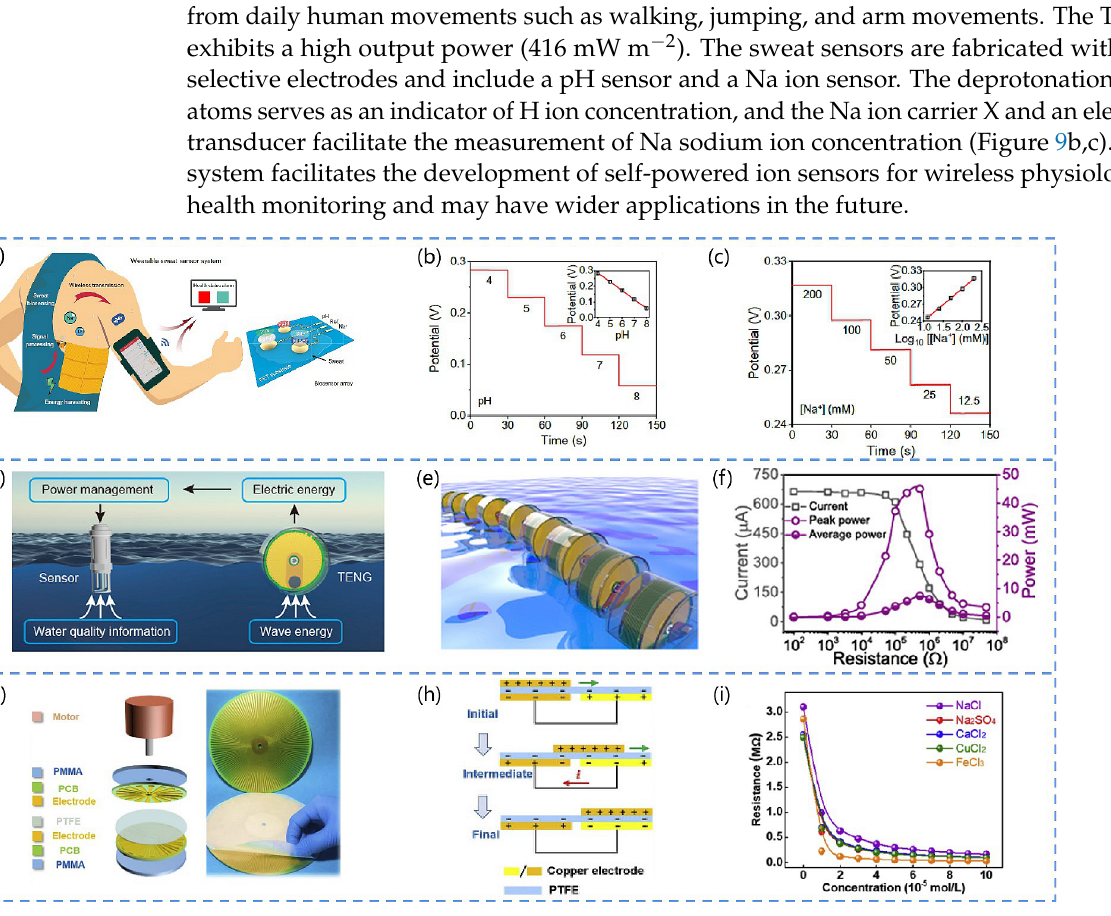
Figure 9. ( a ) Schematic diagram of the TENG-based sweat sensor for the real-time monitoring of health status during human exercise. ( b ) Curves of the open-circuit potential of the pH sensing system in a standard buffer solution. ( c ) Curve of the open-circuit potential of the Na + sensing system in NaCl solution. Reprinted from [67] with permission from Science. ( d ) Schematic diagram of the TENG-based water quality monitoring system. ( e ) Schematic diagram of a TENG with a grating structure to collect water wave energy. ( f ) Output of devices under load resistance. Reprinted from [68] with permission from Elsevier. ( g ) RD-TENG-based sensing system. ( h ) The lateral sliding structure of the TENG. ( i ) Plot of ion concentration and impedance at a frequency of 200 Hz. Reprinted from [69] with permission from Elsevier.